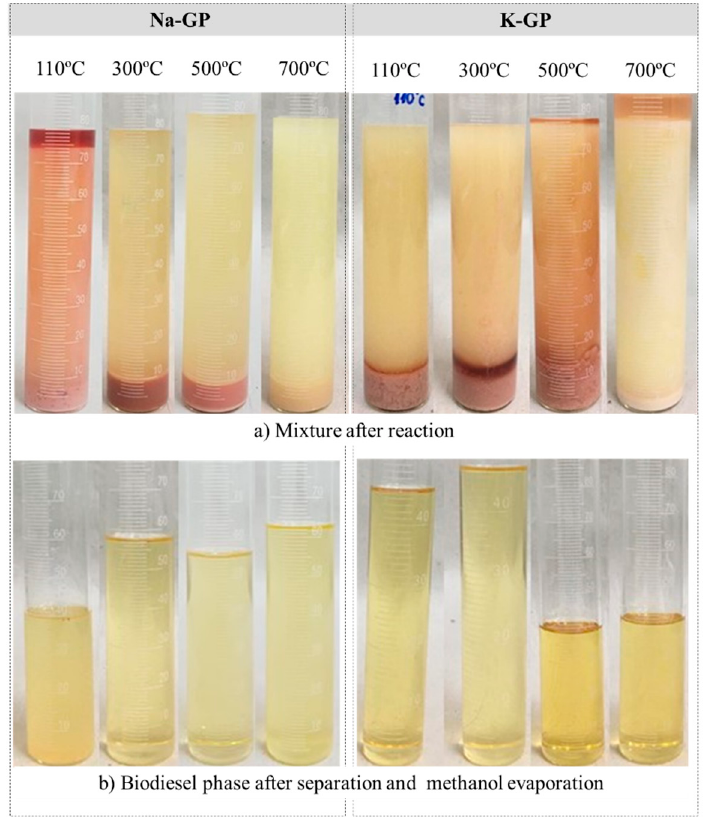
Figure 4. Details of the phases resulting from the transesterification of soybean biodiesel with sodium and potassium geopolymer powders treated at different temperatures. ( a ) Mixture after reaction; ( b ) Biodiesel phase after separation and methanol evaporation.